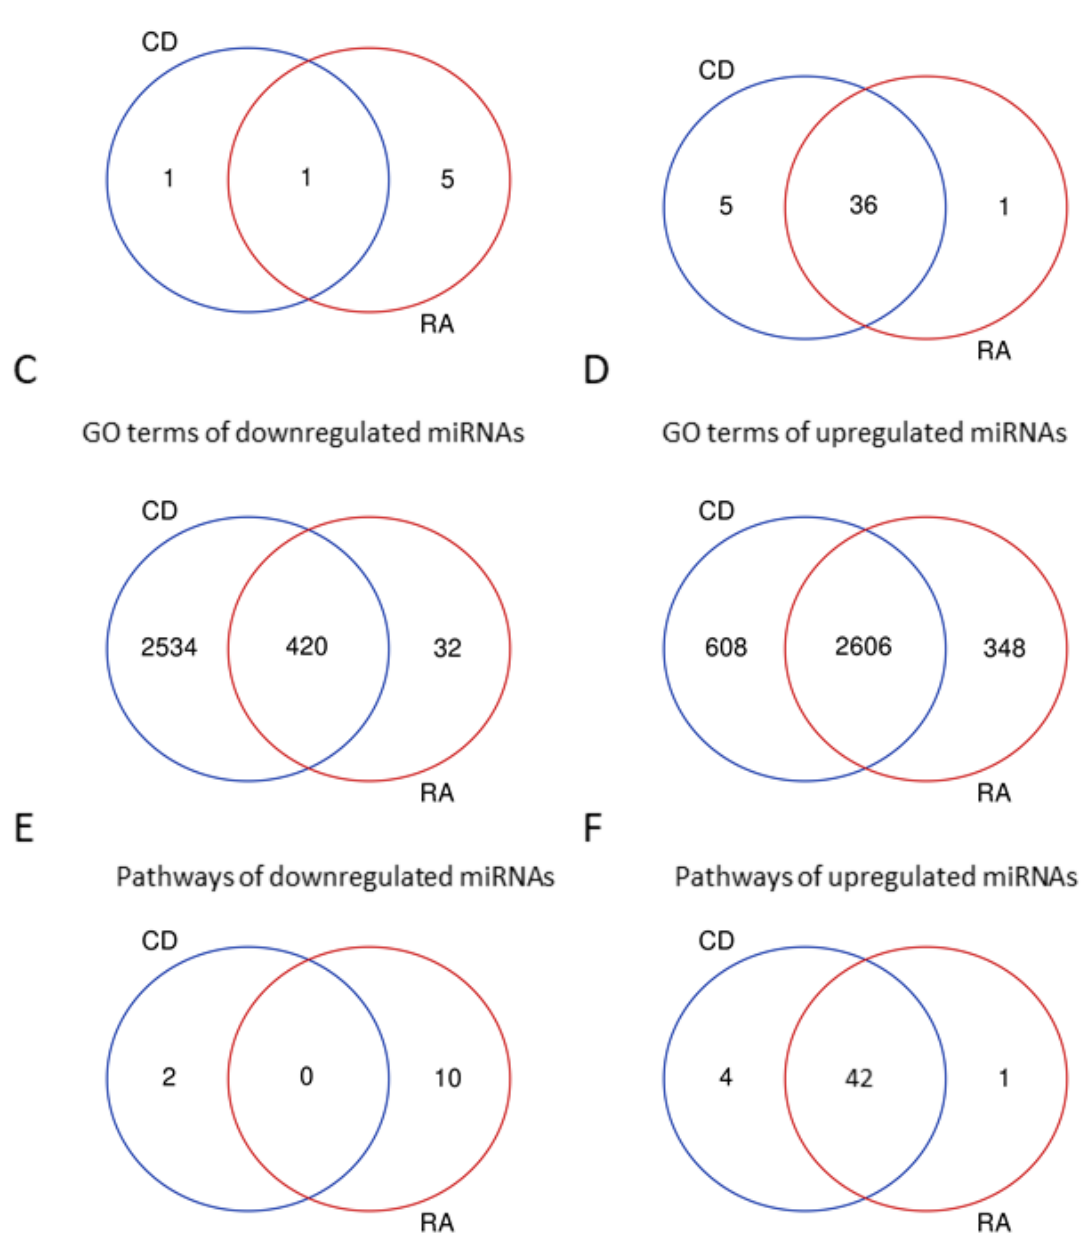
Figure 2. Venn diagram indicating the down regulated ( A ) and up regulated ( B ) miRNAs commonly regulated for RA and CD patients. GO terms for biological processes of down regulated ( C ) and up regulated ( D ) miRNAs and KEGG pathways of down regulated ( E ) and up regulated ( F ) miRNAs in CD and RA patients compared to healthy controls.